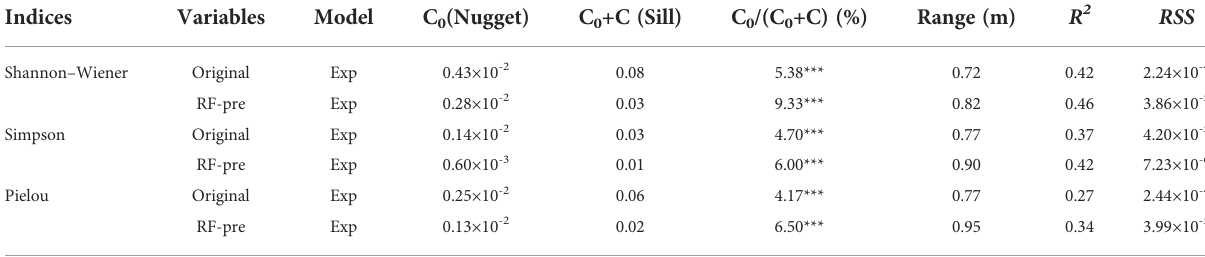
TABLE 4 Parameters of semi-variograms predicted by RF models.